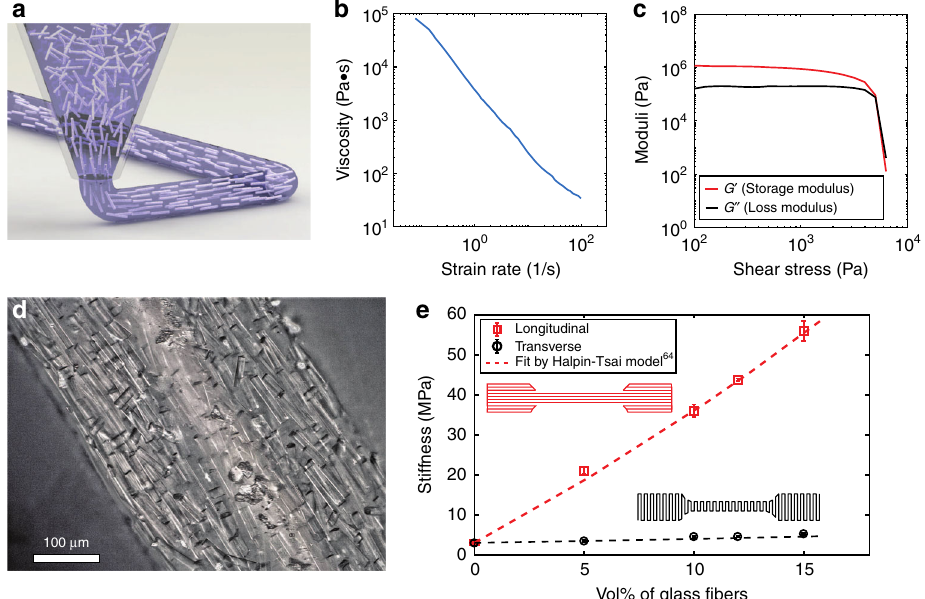
Fig. 2 Direct ink writing (DIW) of PDMS-glass fi ber composites. a Schematic of extrusion of PDMS ink during DIW 3D printing, leading to alignment of glass fi bers. b , c Rheological characterization of the PDMS-GF ink shows shear-thinning and yield-stress behavior, respectively. d An optical micrograph showing material printed using PDMS-GF ink (15 vol% glass fi bers), with alignment of glass fi bers along the print direction. e Stiffness of PDMS-GF composites (after curing of printed structures) as a function of the volume fraction of glass fi bers and the fi ber orientation, based on tensile testing of printed specimens ( “ Longitudinal ” and “ Transverse ” indicate printing and fi ber orientation that is parallel with or perpendicular to the loading direction, respectively), and fi t using the Halpin – Tsai model